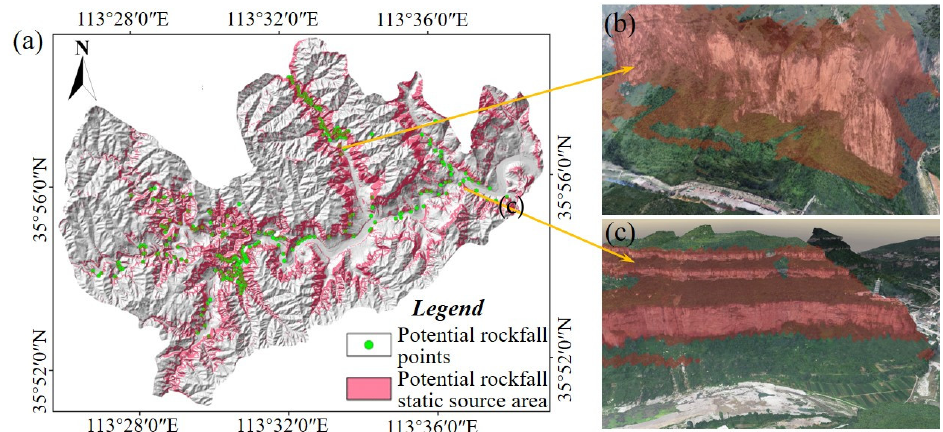
Figure 14. Verification of static identification results of potential rockfall source areas. ( a ) Compari- son of the identification results with the field investigation of potential rockfall points. ( b ) The slope near the entrance of Baquan Gorge. ( c ) The slope near the Foshou Pagoda in Qinglong Gorge.